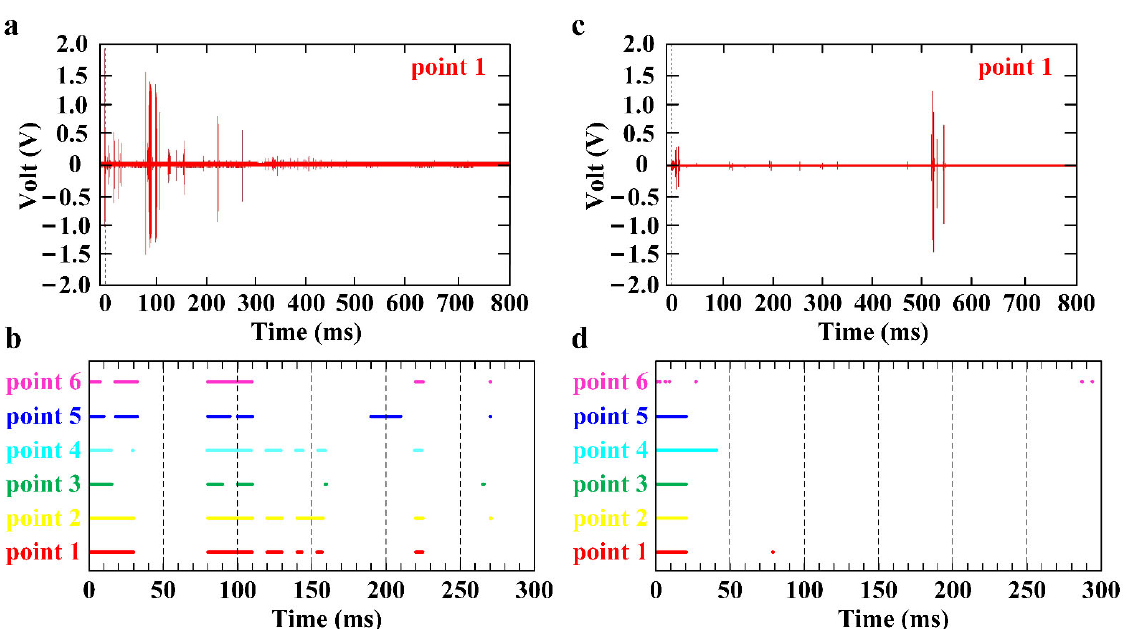
Figure 3. Electromagnetic radiation signal of TNT explosion. ( a ) Full ‐ time electromagnetic radiation signal of 60 kg TNT explosion; ( b ) time ‐ domain distribution of electromagnetic radiation of 60 kg TNT explosion; ( c ) full ‐ time electromagnetic radiation signal of 30 kg TNT explosion; ( d ) time ‐ do ‐ main distribution of electromagnetic radiation of 30 kg TNT